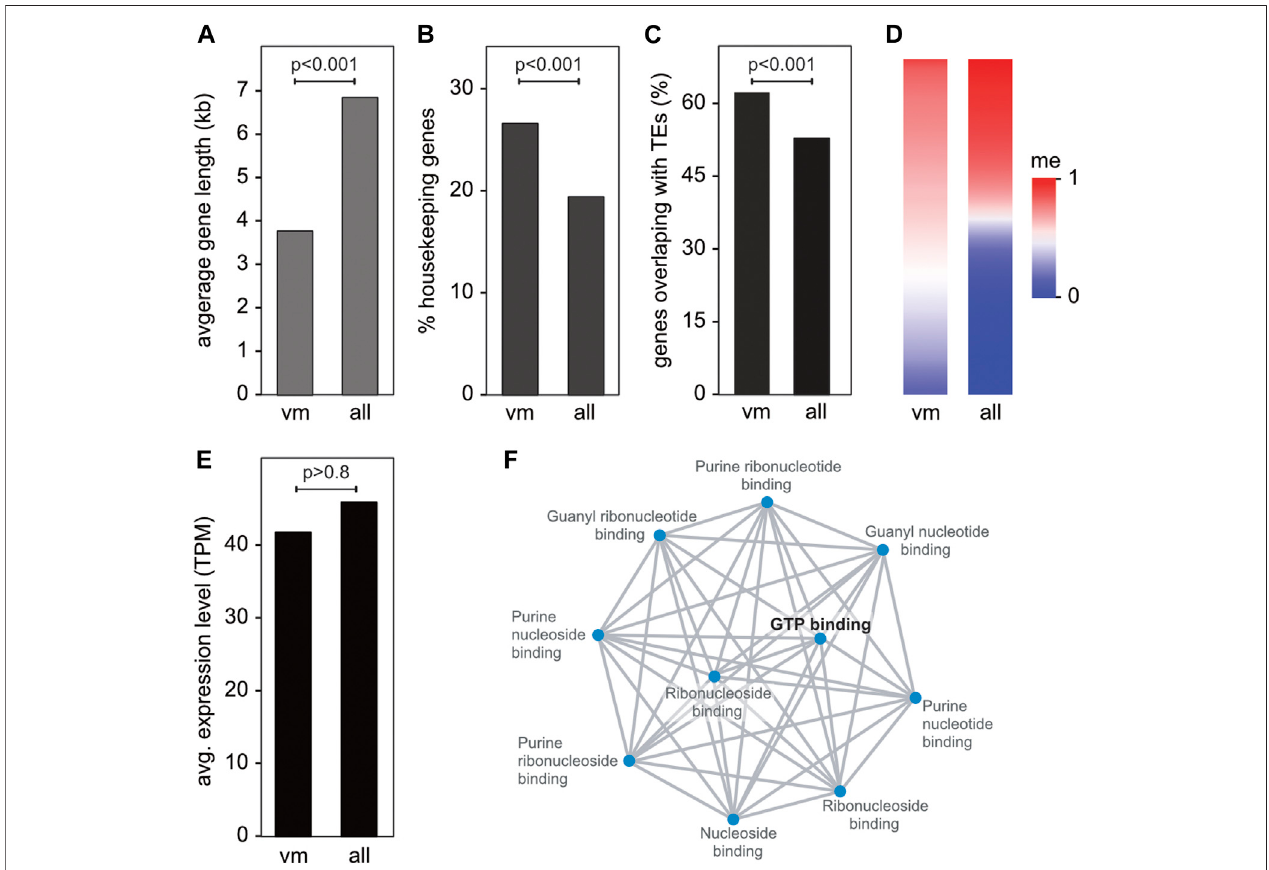
FIGURE3| Characterizationandfunctionalannotationofthecoresetof361variably methylatedgenes. (A) Averagegenelengthofvariably methylated(vm)genes vs. all genes. (B) Percentage of housekeeping genes in the variably methylated gene set vs. all genes. (C) Percentage of variably methylated genes vs. all genes overlapping with transposable elements (TEs). (D) Heatmap depicting the average methylation of variably methylated genes and all genes. (E) Average gene expression ofgenesinthevariablymethylatedgenesetvs.allgenes. (F) NetworkvisualizationofenrichedGOmolecularfunctiontermsofvariably methylatedgenes.Adjusted p -values are < 0.0002 for all